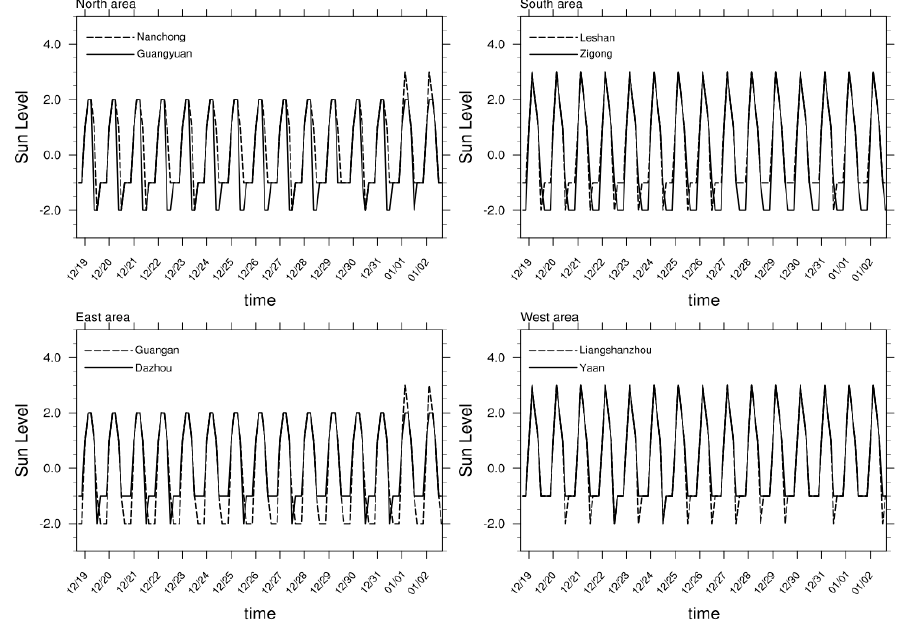
Figure 5. The sunshine level variations in the eight cities in the four areas.